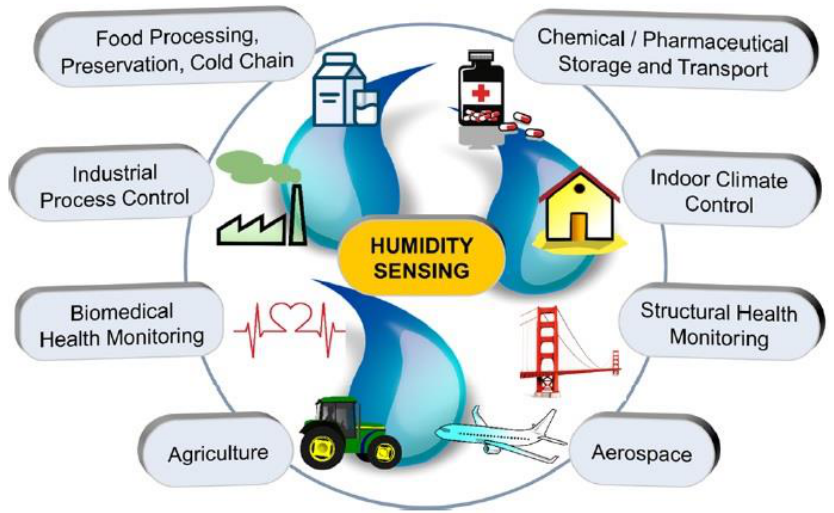
Figure 3. Various application paradigms of humidity sensors. Reprinted from [21]. Published 2021 by ACS as open access.